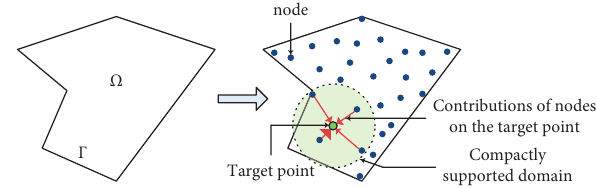
Figure 2: The shape function denotes the field value contribution of all nodes on a target point. By setting a compactly supported domain, the shape function is sparse and the compressive sensing can be used to recover the source